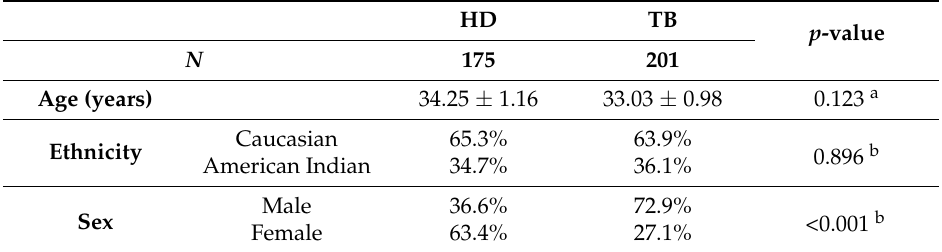
Table 1. Demographic characteristics of healthy donors (HD) and tuberculosis (TB) populations. HD